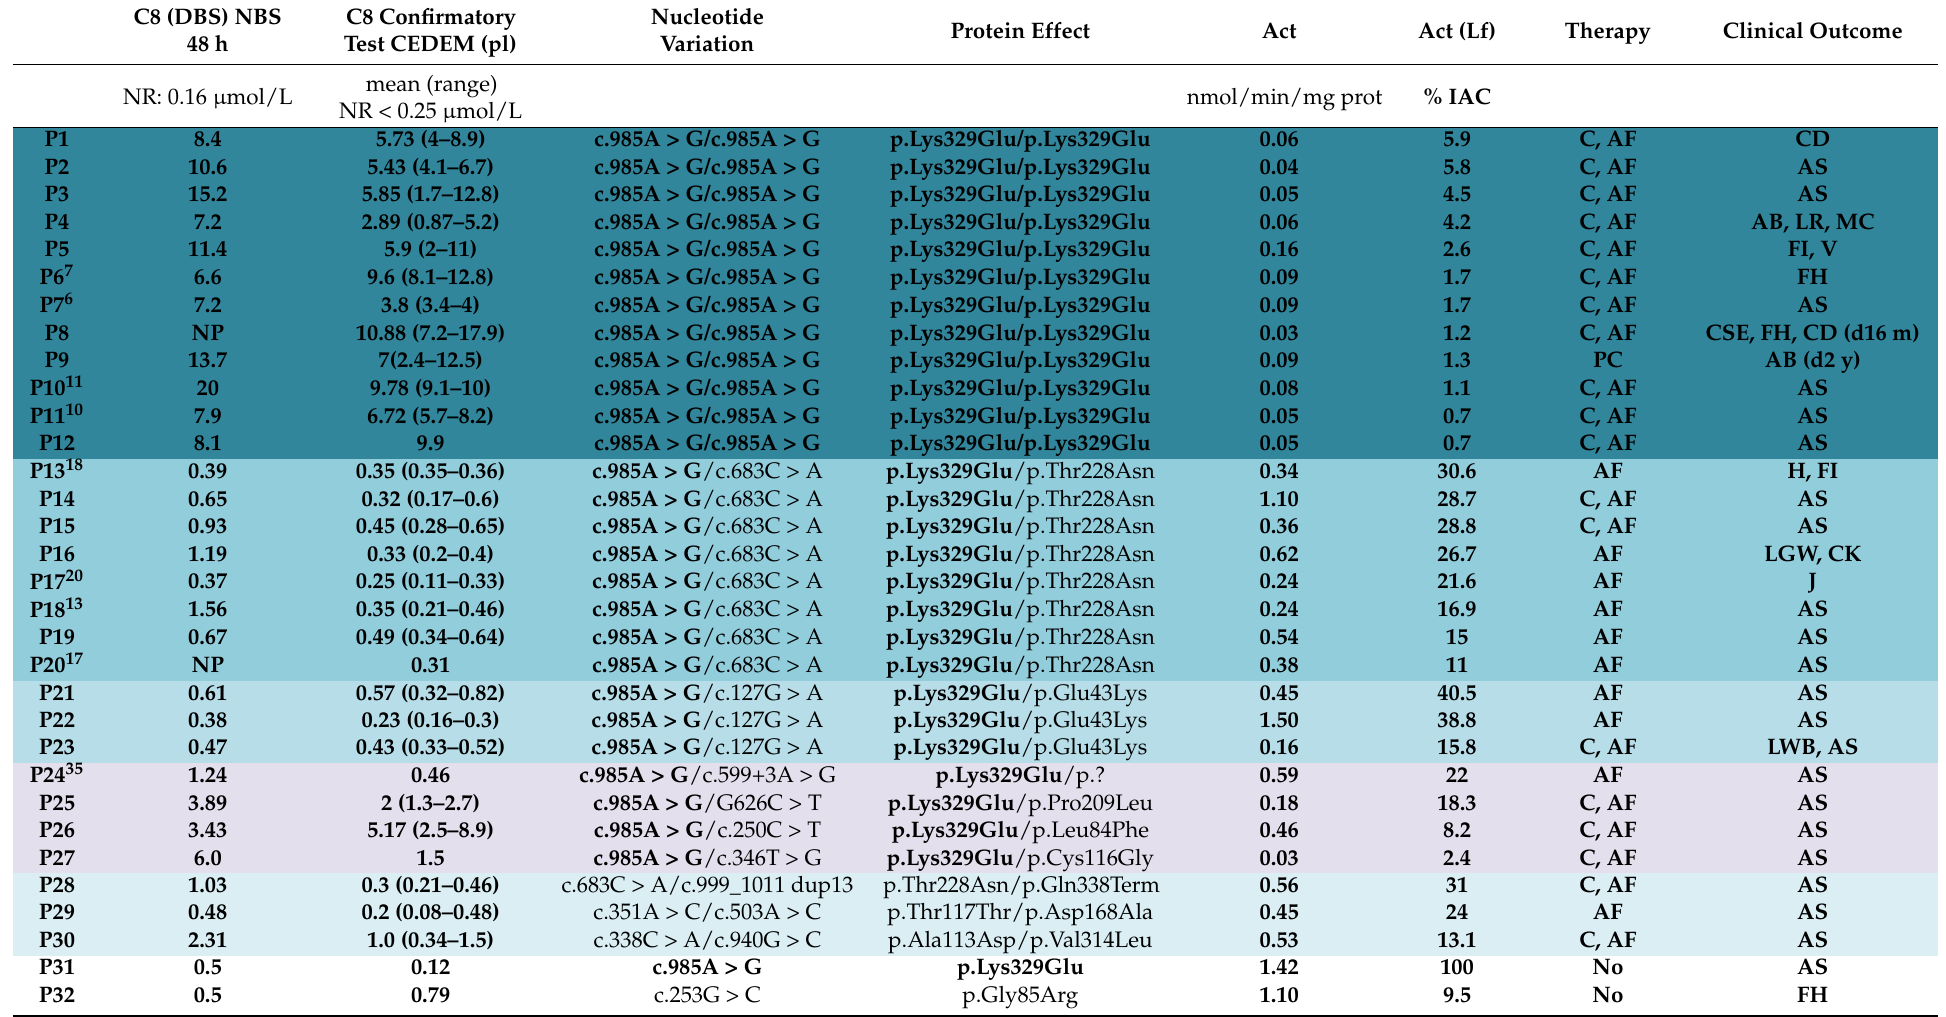
Table 1. Clinical, biochemical, and molecular findings in MCADD